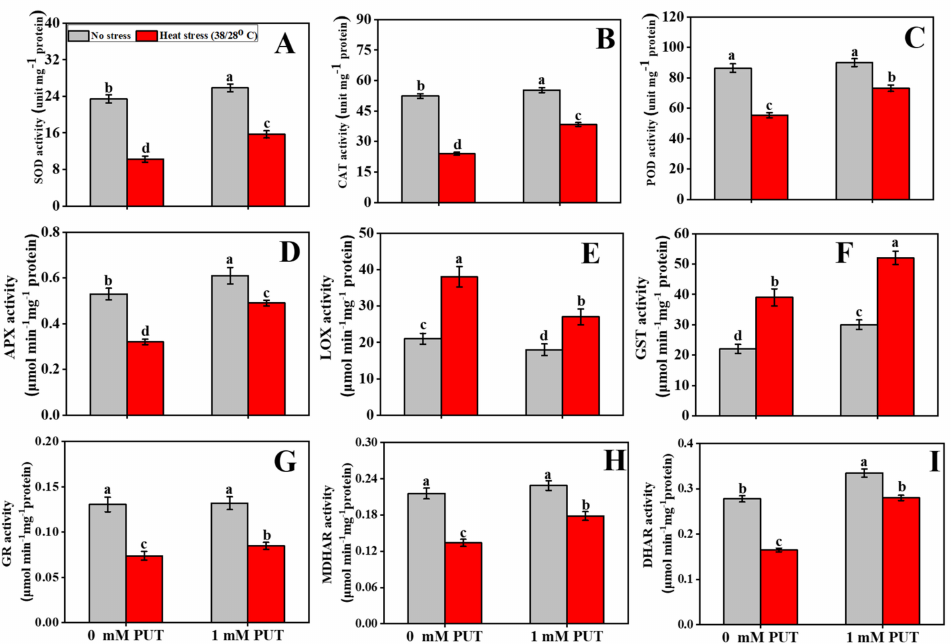
Figure 8. Interactive effects of Putrescine and high temperature on antioxidant enzymes activity in tomato seedlings. ( A ) Superoxide dismutase (SOD) activity, ( B ) Catalase (CAT) activity, ( C ) Peroxi- dase (POD) activity, ( D ) Ascorbate peroxidase (APX) activity, ( E ) Lipoxygenase (LOX) activity, ( F ) Glutathione S-transferase (GST) activity, ( G ) Glutathione reductase (GR) activity, ( H ) Monodehy- droascorbate reductase (MDHAR) activity, and ( I ) Dehydroascorbate reductase (DHAR) activity. The data denote the mean value ± standard error (n = 3). Different alphabetic letters represent significant differences among the treatments at p < 0.05, according to Tukey’s